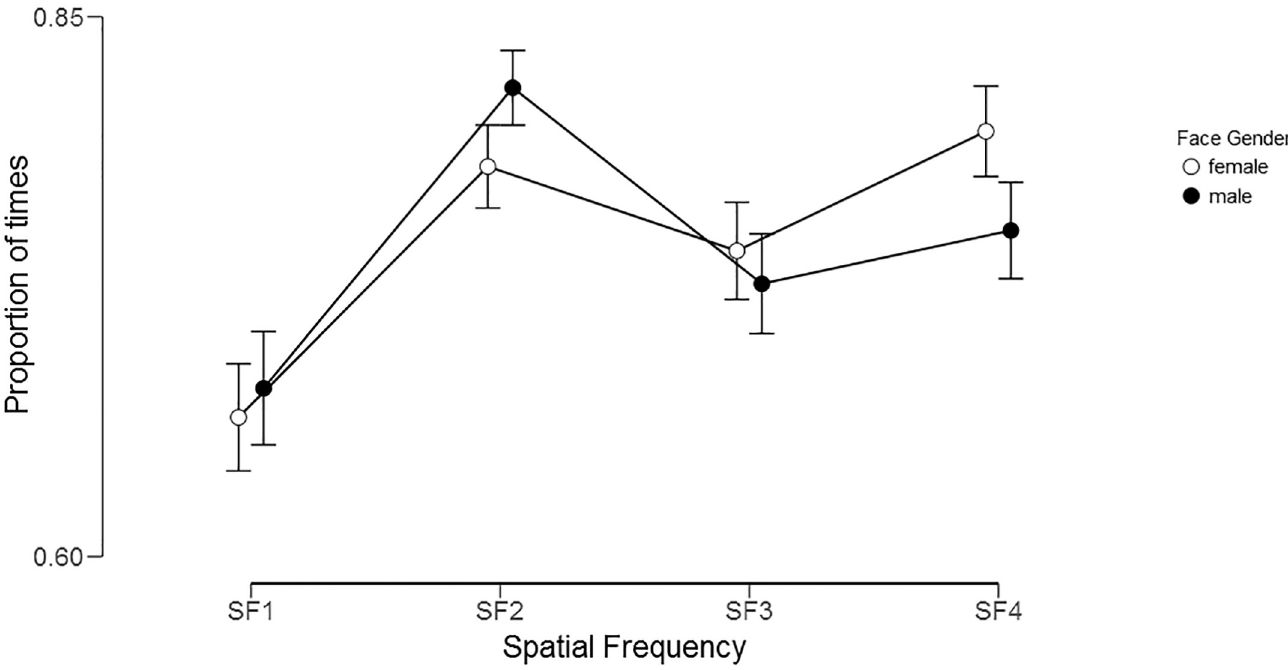
Fig 3. Proportion of times participants groups selected the same face as the most attractive of a pair in both the unfiltered (broadband) faces condition and in a filtered faces condition, split by Face Gender (black circles = male faces; white circles = female faces). SF 1 = low-pass filtered face; SF 2 = medium-low-pass filtered face; SF 3 = medium-high-pass filtered face; and SF 4 = high-pass filtered face. Error bars represent the 95% confidence intervals.